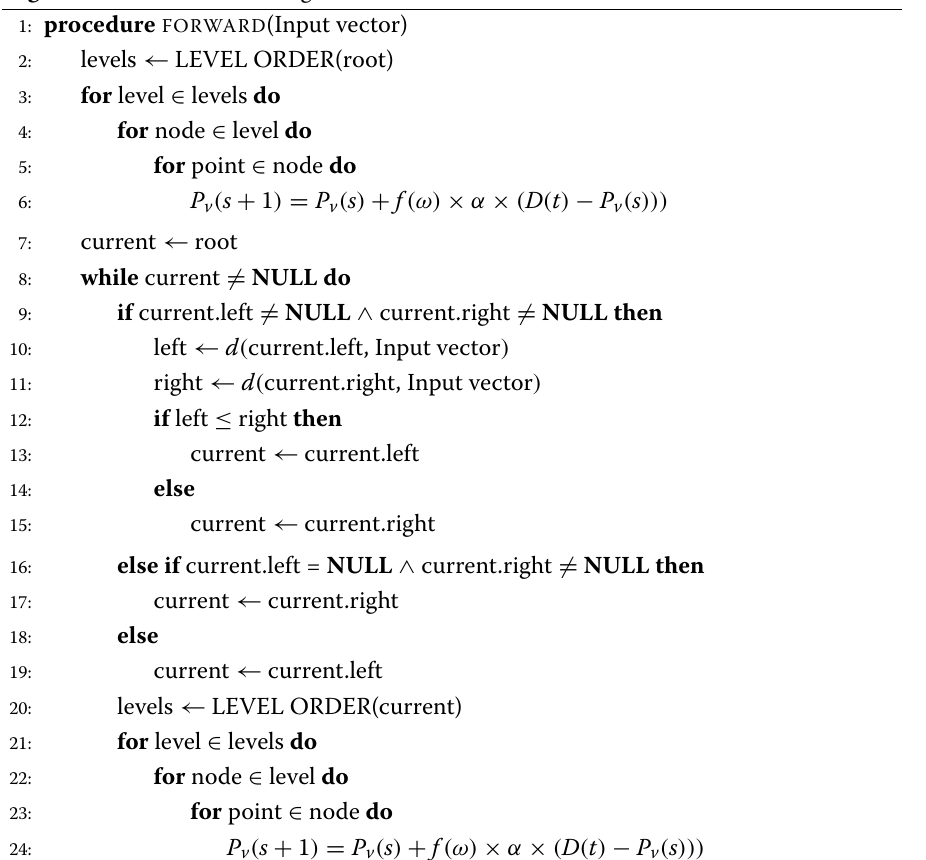
Algorithm 4 Forward training of Neural